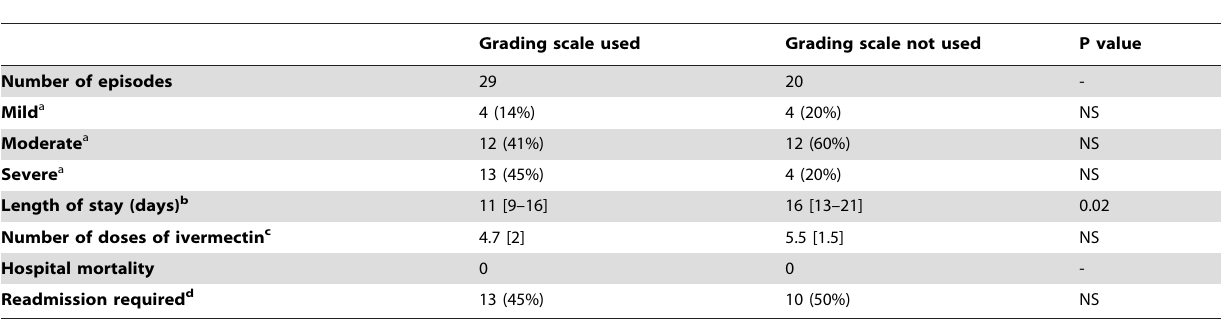
Table 3. Relationship between prospective use of the grading scale and clinical